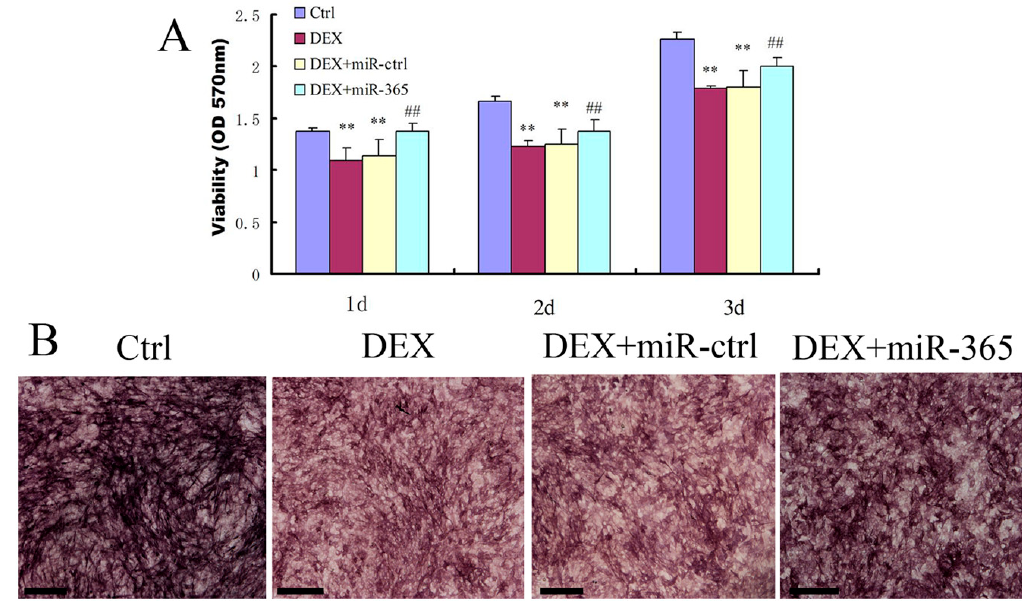
Figure 2. MiR-365 over-expression ameliorated DEX-induced inhibition of osteoblast cell viability and alkaline phosphatase activity. The cells were transfected with miR-365 mimic or miRNA mimic negative control. After 12 h, the cells were treated with 1 µM DEX or vehicle control. ( A ) CCK-8 assay was performed to test the viability on days 1, 2, and 3 ( n = 6). ( B ) Alkaline phosphatase activity was detected by BCIP/NBT staining on day 7. ** p < 0.01 compared to control; ## p < 0.01 compared to DEX+miR-ctrl. Scale bar: 200 µm.